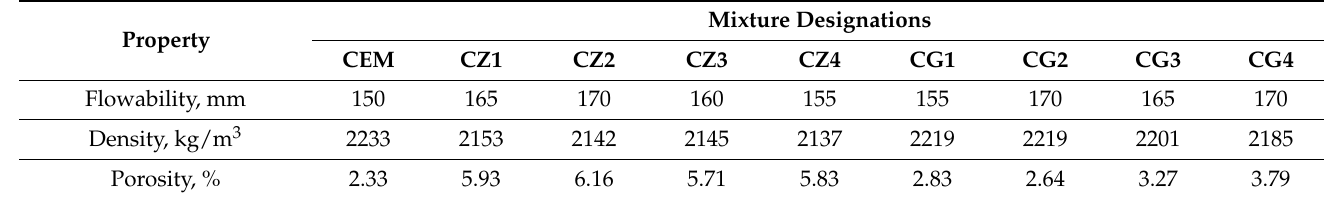
Table 6. The main properties of fresh cement mortars No